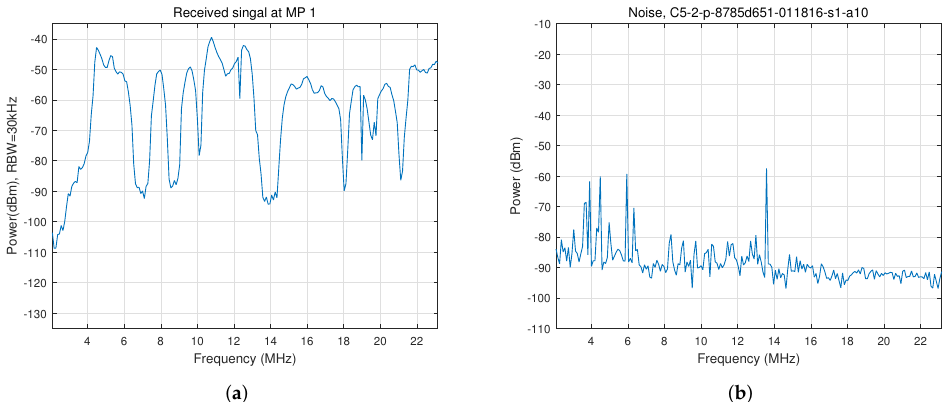
Figure 7. Spectra of the received and noise signals. ( a ) Signal power spectrum P z ( f k ) of the received signal z ( t ) from (4). ( b ) Noise power spectrum P n ( f k )